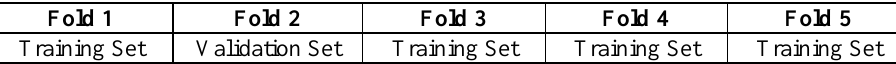
Table 5: 5-Fold cross validation